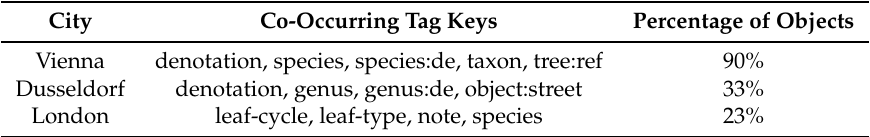
Table 15. The most frequently occurring tag keys with the natural=tree target tag for three cities. City Co-Occurring Tag Keys Percentage of Objects Vienna denotation, species, species:de, taxon, tree:ref 90% Dusseldorf denotation, genus, genus:de, object:street 33% London leaf-cycle, leaf-type, note, species